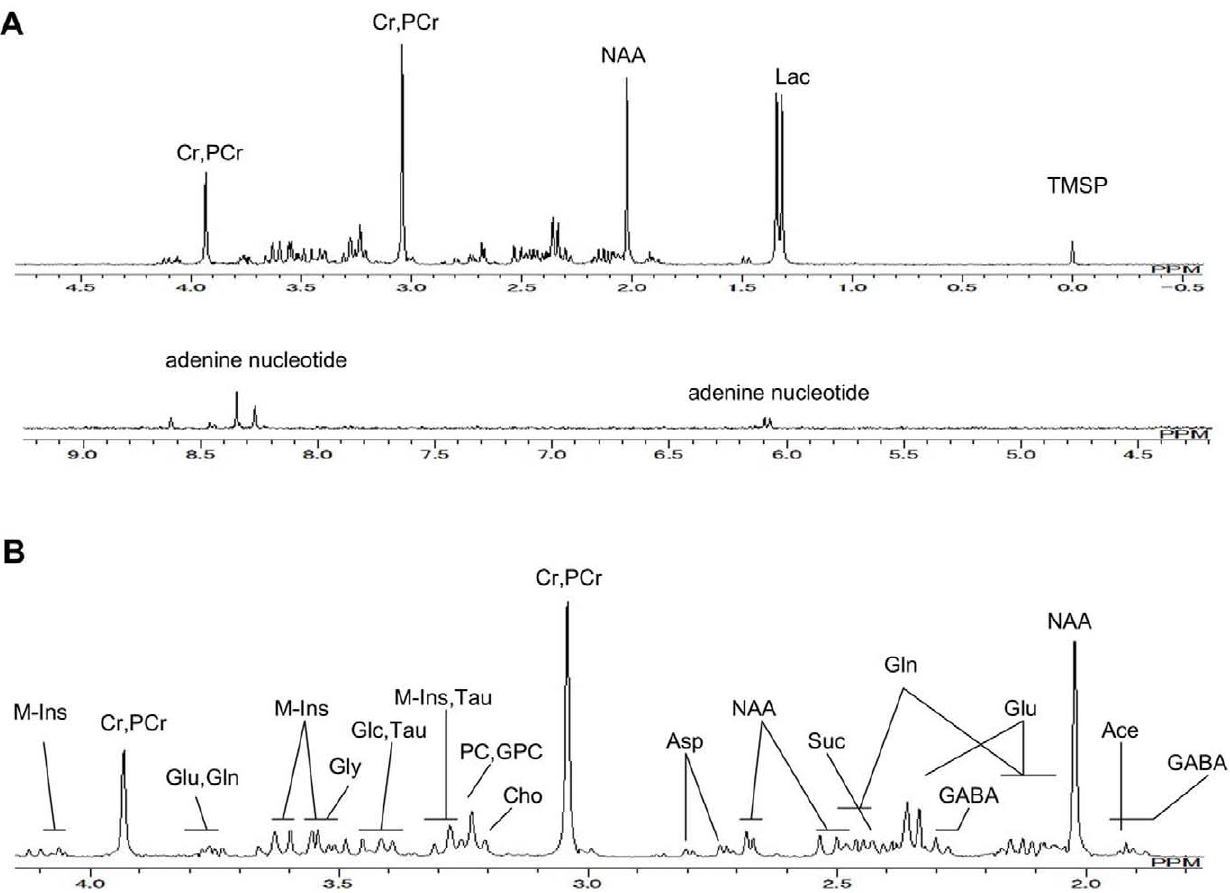
Figure 2. Proton NMR spectrum of a hydrophilic brain extract in a control rat. (A) 0.00 ppm to 9.00 ppm and (B) 2.00 ppm to 4.00 ppm (Ace. Acetate: Asp. Aspartate: Cho. Choline: Cr. Creatine: GABA. gamma-aminobutyric acid: Glc. Glucose: Gln. Glutamine: Glu. Glutamate: Gly. Glycine: GPC. Glycerophosphorylcholine: M-Ins. Myo Inositol: NAA. N-acetyl aspartate: PC. Phosphorylcholine: PCr. Phosphocreatine: Suc. Succinate: Tau. Taurine). doi:10.1371/journal.pone.0011172.g002 PLoS ONE |